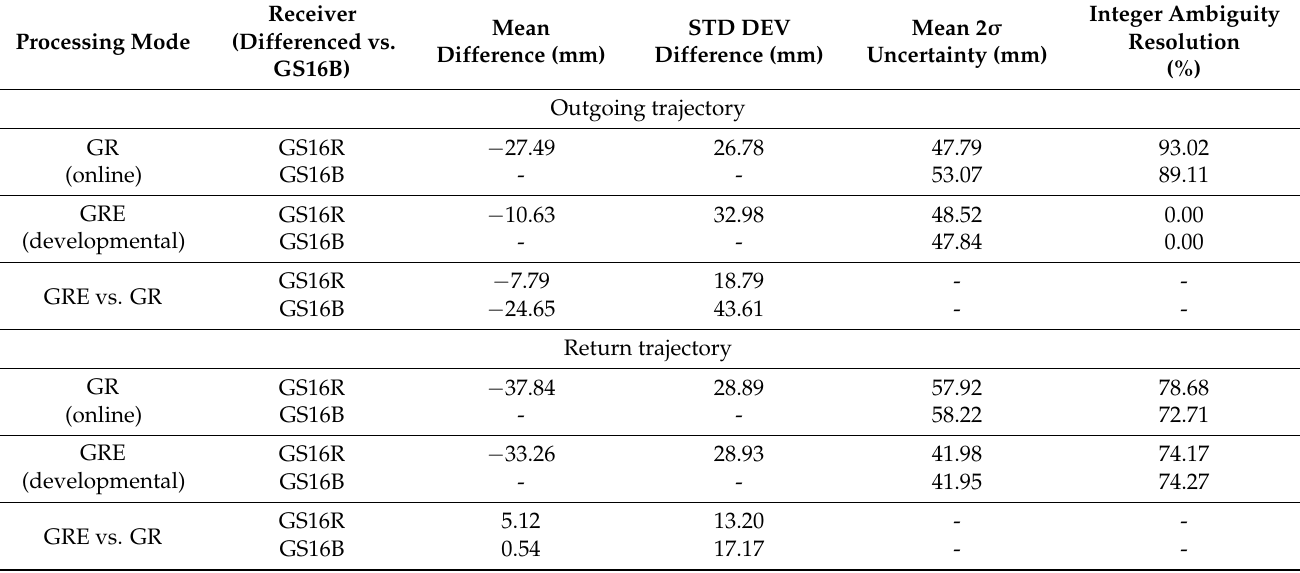
Table 4. Kinematic dataset B height profile mean differences, standard deviations, and integer ambiguity resolution success rates for GR and